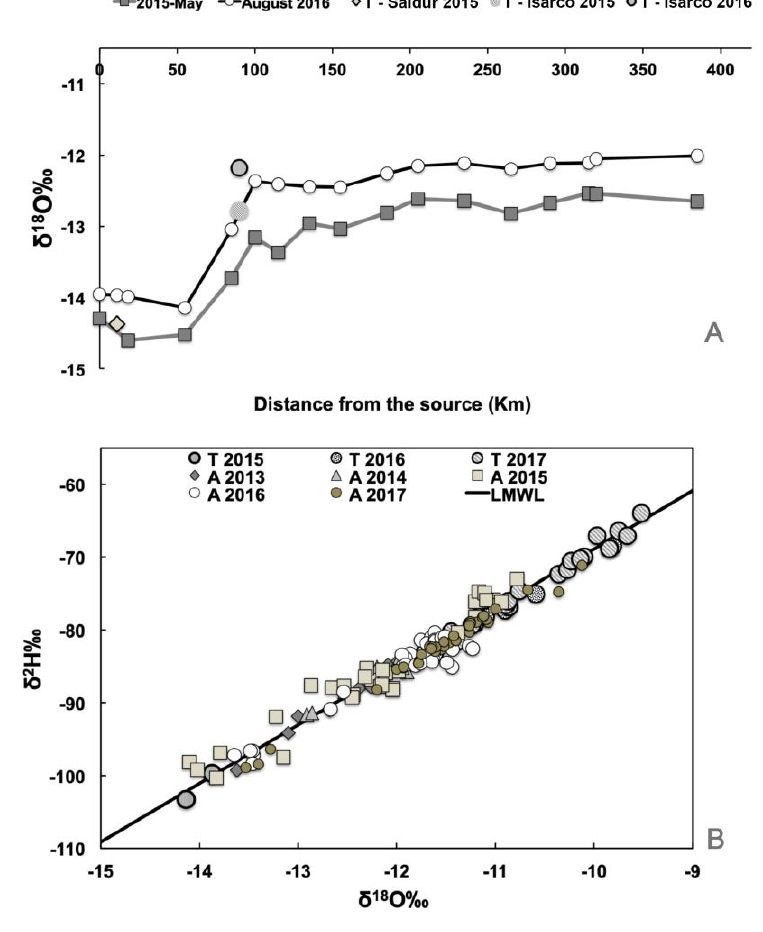
Figure 2. ( A ) Spatial variation in the δ 18 O of Adige river water from the source to the estuary, recorded in May 2015 [18] and August 2016; ( B ) δ 18 O–δ 2 H of Adige river water ( A ), the main tributaries (T) and the meteoric water lines defined for northern Italy by Giustini et al. [49]. The reported values are the original data presented in this study (Table 1) supplemented by data from the literature [18–34].